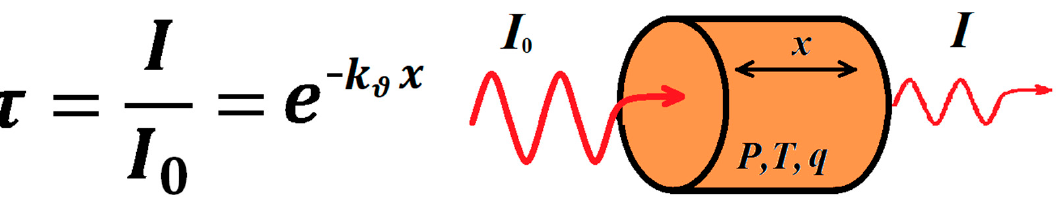
Figure 1. Lambert–Beer law’s graphic representation, k ϑ is the absorption coefficient. P , T , and q respectively pressure, temperature, and concentration in sensing volume.